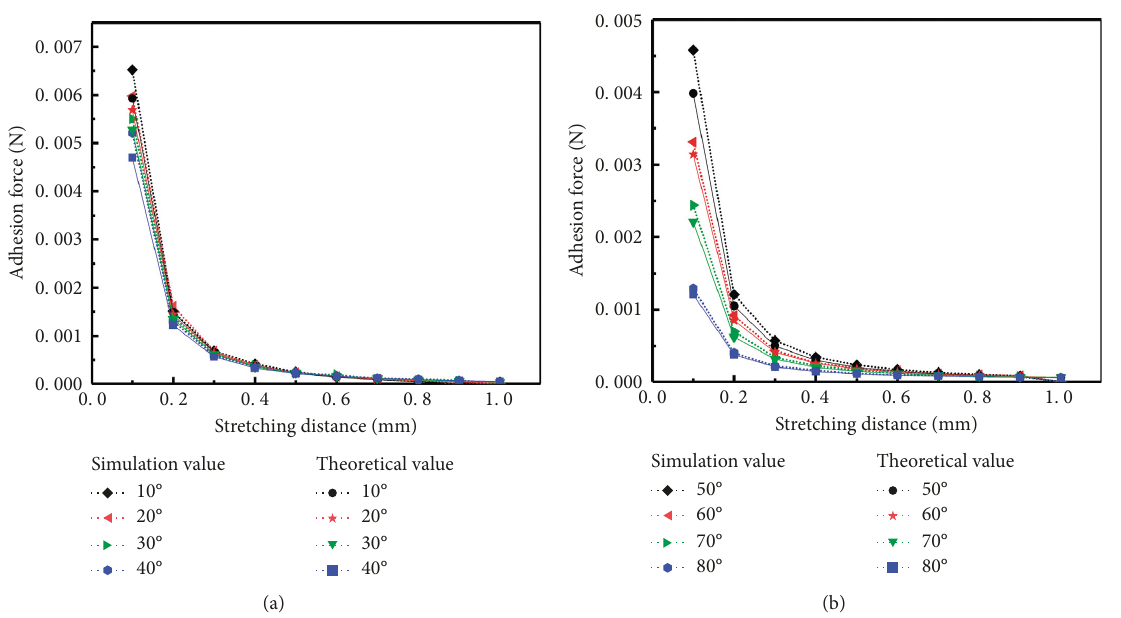
Figure 10: (a) Comparison of simulation value and theoretical value of adhesion force change trend at 10 ° –40 ° . (b) Comparison of simulation value and theoretical value of adhesion force change trend at 50 ° –80 °